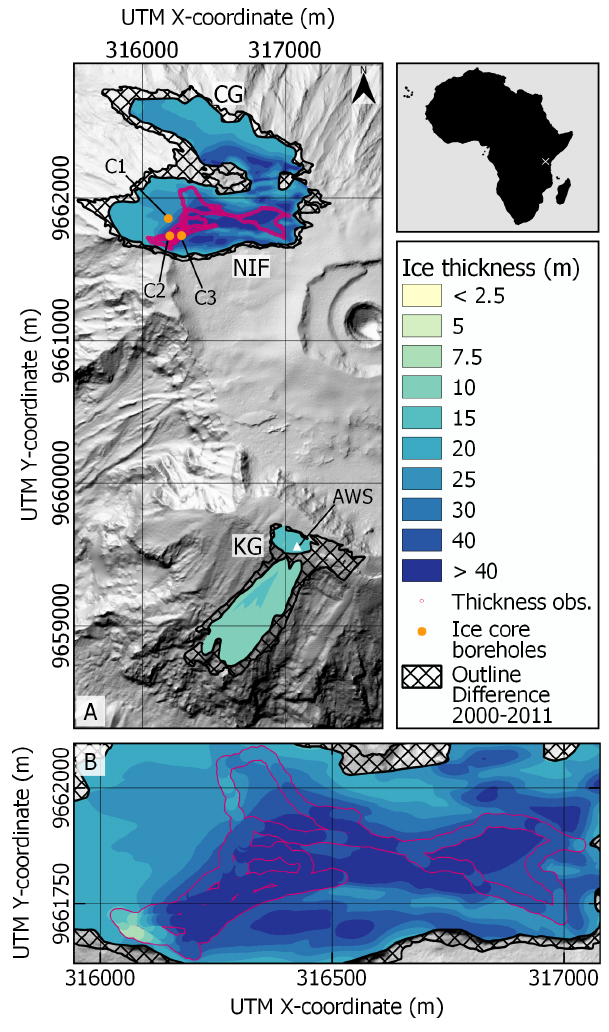
Figure 1. Reconstructed ice thickness (m) for the Northern Ice Field (NIF) and Kersten Glacier (KG) for the year 2011 based on thick- ness observations (NIF) and mean viscosity (KG), with a model resolution of 2m (Experiment 3). The magenta path on the NIF represents the GPR ice thickness measurements by Bohleber et al. (2017). Orange dots (C1–C3) indicate the drill locations of the ice cores from Thompson et al. (2002). The AWS location from Mölg et al. (2009) is marked by the white triangle. Background: KIL- ISoSDEM hillshade. The overview map depicts the location of Mt. Kilimanjaro (white cross) on the African